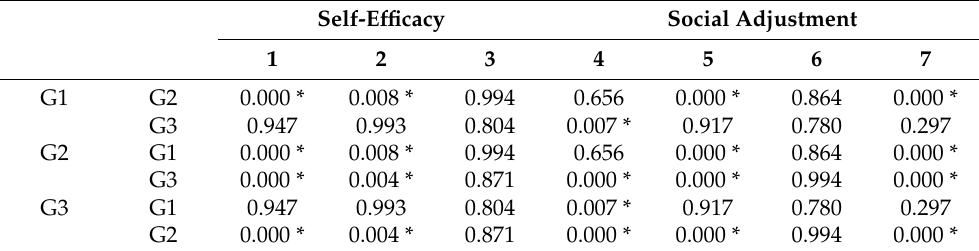
Table 6. Results of post-hoc